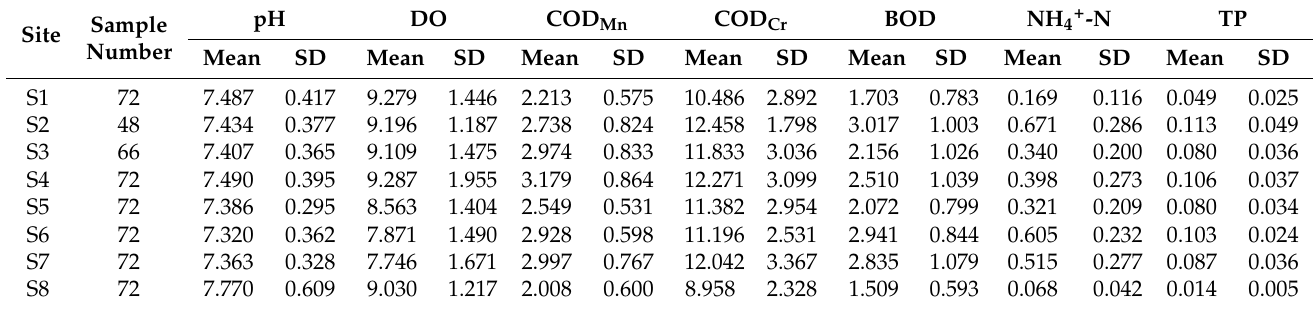
Table 3. Water quality characteristics in different sampling